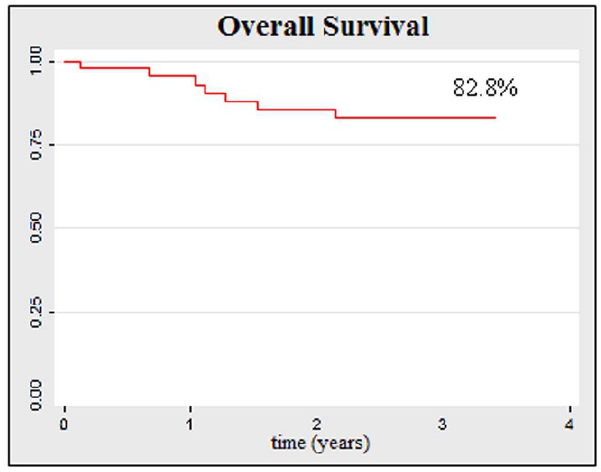
Figure 2 - Overall survival in DLBCL patients treated with R-CHOP at the Hematology Department of